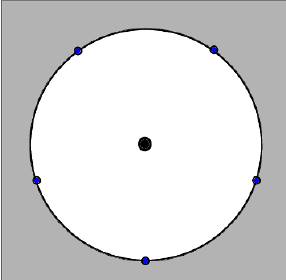
Figure 18. CP 1 n D 1 where D 1 is a disk around z = 1 bounded by S 1 with (cid:12)ve marked points colored in blue. The regular singularity at z = 0 is colored in